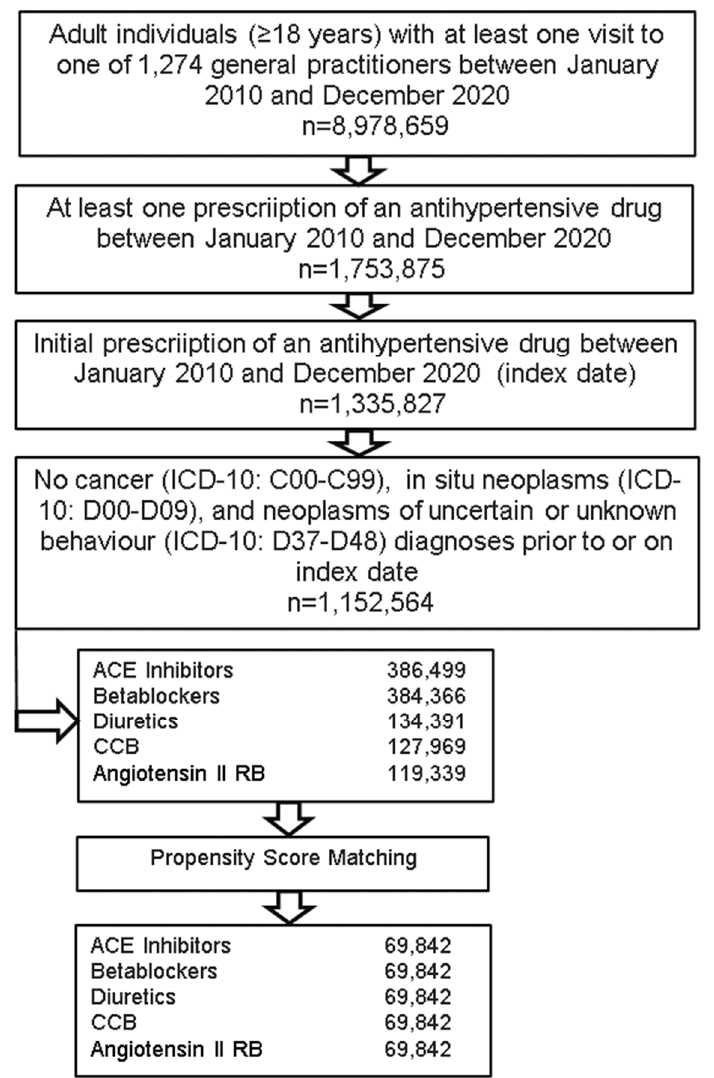
Figure 1. Selection of study